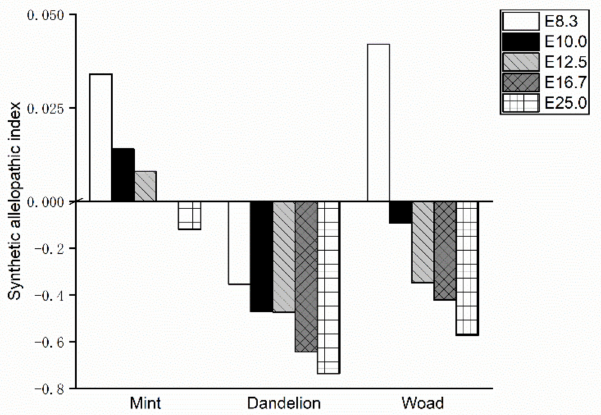
Figure 6. Allelopathic effects of fig tree leaf aqueous extracts at different concentrations on three medicinal plants. SE was calculated as the average allelopathic index (RI) of all indicators with each treatment of three medicinal plants. CK, 0.0 g/L; E8.3, 8.3 g/L; E10.0, 10.0 g/L; E12.5, 12.5 g/L; E16.7, 16.7 g/L; E25.0, 25.0